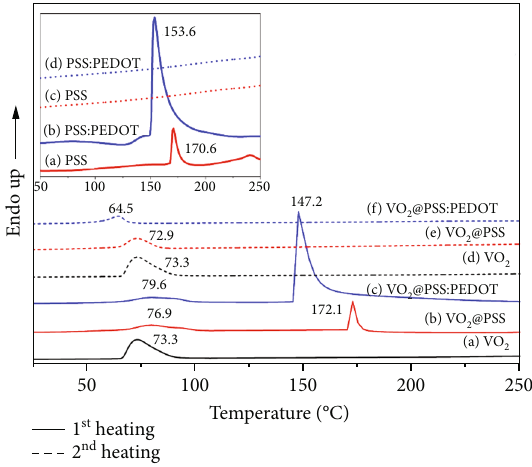
Figure 8: DSC thermograms of various VO (a) the neat VO , (b) VO @PSS, and (c) VO 2 2 that the dot lines represent the second heating thermograms for each sample.